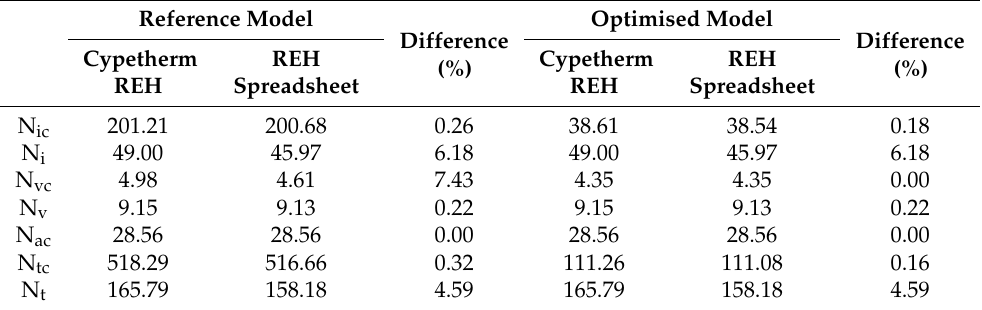
Table 5. Comparison between the Cypetherm REH results and REH spreadsheet results—existing